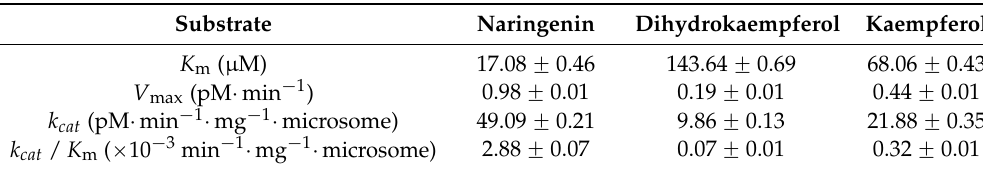
Figure 4. HPLC chromatograms of products from yeast cells with naringenin, dihydrokaempferol and kaempferol as substrates. HPLC chromatograms of products from pYES-dest52- CsF3 ’ H with naringenin ( A ), dihydrokaempferol ( C ) and kaempferol ( E ) as substrates; HPLC chromatograms of products from the control with naringenin ( B ), dihydrokaempferol ( D ) and kaempferol ( F ) as substrates. Table 1. Steady-state kinetic parameters for CsF3’H in microsomes.